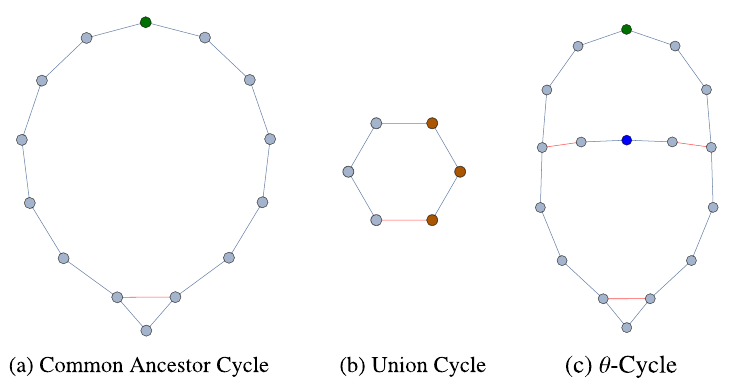
Fig. 11 Left: A common ancestor cycle. The top most vertex is a common ancestor of the lowest vertex. The horizontal red line is a marriage, all other lines are parent–children edges. Center: A union cycle, specifically the double cousin situation described in "Background: genealogical and social networks". The left-most and right-most vertices are parents of their neighboring vertices. The two horizontal red lines are marriage edges. Right: A θ -cycle formed by a common ancestor cycle with two overlapping hybrid